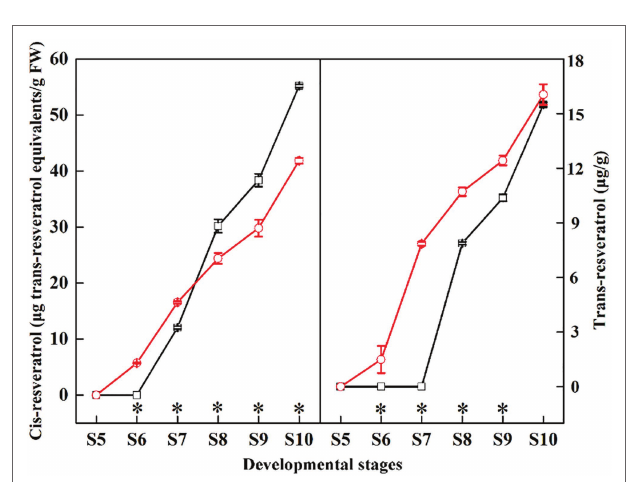
FIGURE 3 | The changes in the contents of trans -resveratrol and cis - resveratrol during grape berry development and ripening in ‘Summer Black’ (black line) and ‘Nantaihutezao’ (red line). * Indicates the significant differences ( p < 0.05, n =